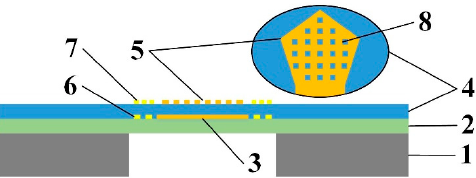
through-holes in top electrode. 1—Silicon substrate; 2—Silicon nitride support film; 3—Bottom electrode; 4—ZnO piezoelectric film; 5—Top electrode; 6—Resistor heater; 7—Resistor temperature sensor; 8—Micro through hole.